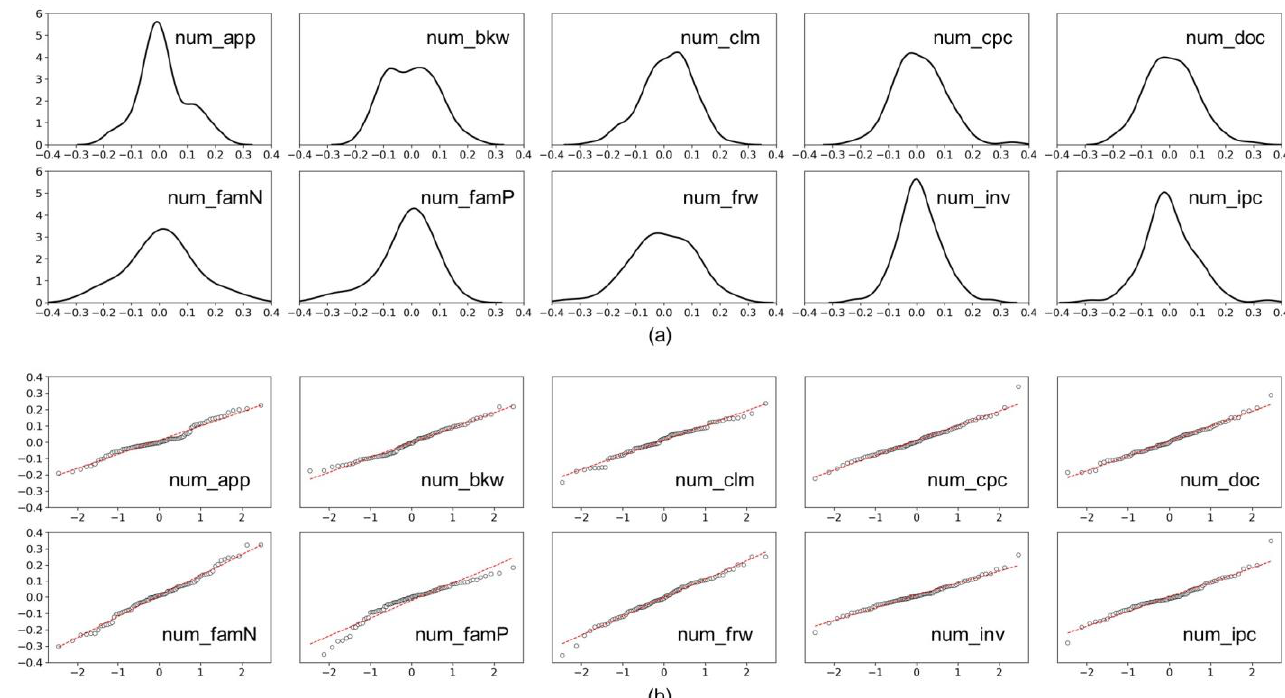
Figure 2. Visualization of the weight distribution of a trained Bayesian neural network. ( a ) Joint probability density distribution for the layers of each factor; ( b ) Q – Q plot of the distribution of each factor layer and standard normal distribution.